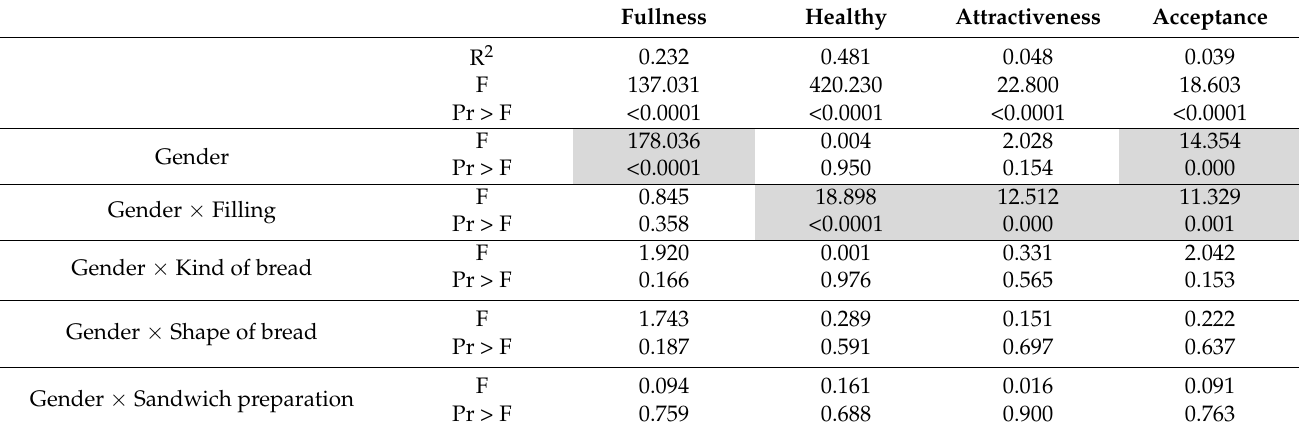
Table 8. F-test in two-way ANOVA for